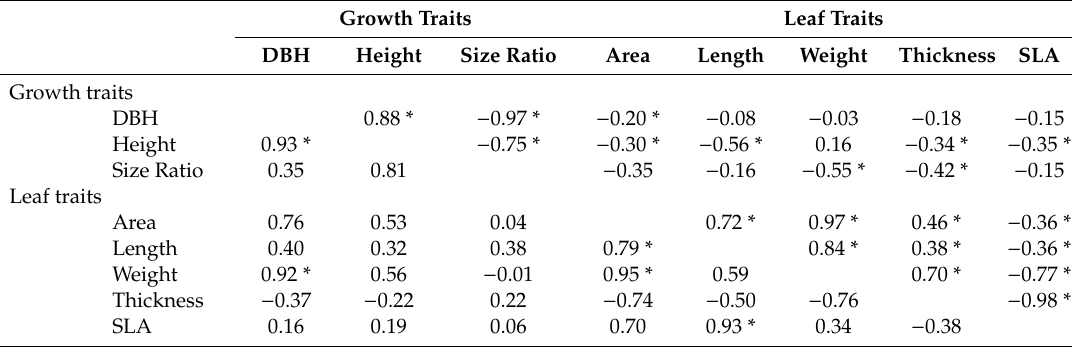
Table 3. Family-level (upper right) and provenance-level (lower left) genetic correlations between traits in Eucalyptus microcarpa (Grey box). Note leaf density excluded due to no additive variance